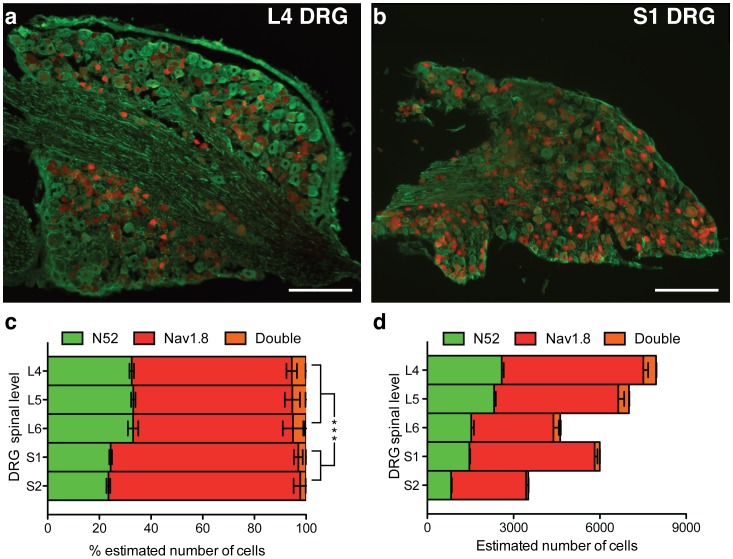
The DRG innervating the hindpaw and tail consist of different ratios of neuronal subpopulations.Example section of an L4 (a) and an S1 (b) DRG (N52: green, Nav1.8: red, scale bar = 250 µm). Overall percentage of estimated number of N52, Nav1.8 and double stained cells within L4 (n = 52), L5 (n = 43), L6 (n = 32), S1 (n = 18) and S2 (n = 17) DRG (c). Total estimated number of N52, Nav1.8 and double-stained cells within L4 (n = 52), L5 (n = 43), L6 (n = 32), S1 (n = 18) and S2 (n = 17) DRG (d). All data analysed by two-way analysis of variance followed by a Bonferroni post-hoc test. Results are presented as mean ± S.E.M. ** P<0.01 and *** P<0.001 (individual points).